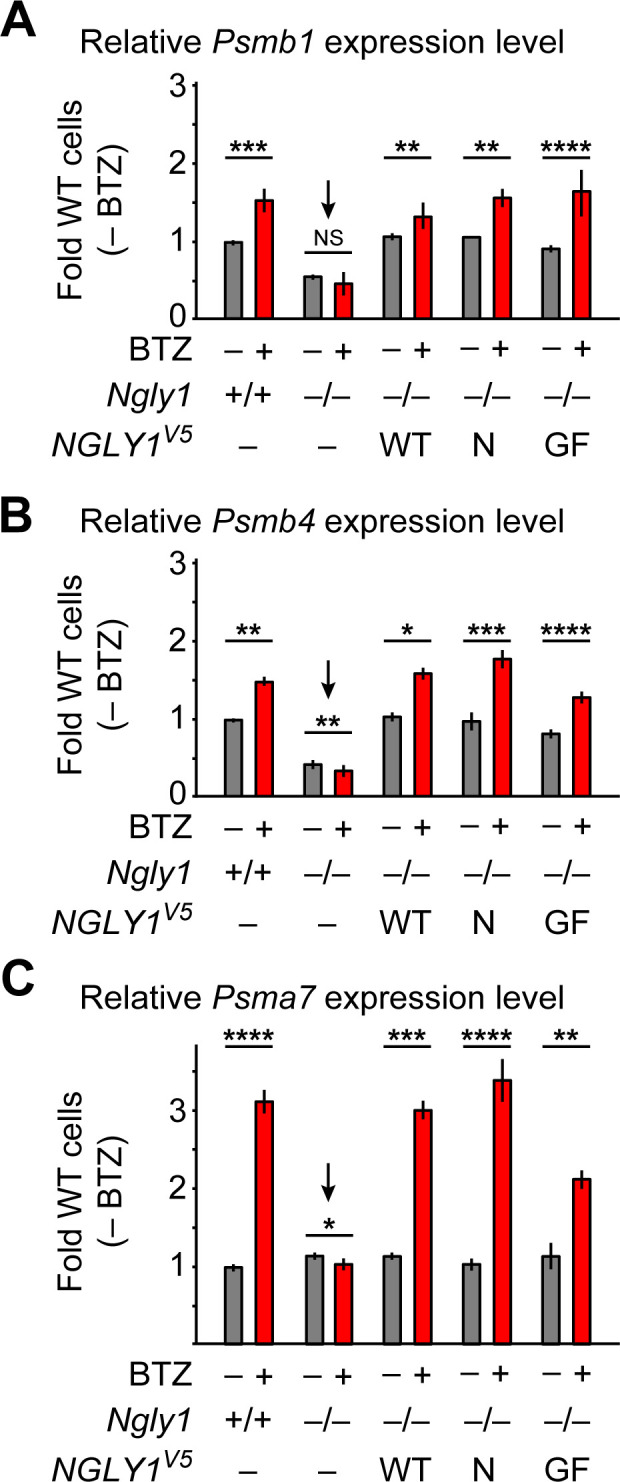
ER-associated NGLY1 is not required for NFE2L1-mediated proteasome bounce-back.(A–C) qRT-PCR assays for proteasome subunit genes in WT and Ngly1 mutant MEFs with or without bortezomib (BTZ) treatment. Ngly1 mutant MEFs were transfected with NGLY1V5-WT and NGLY1V5 with mutations in VCP-binding sites (N41P and G79A/F80A). n = 3 biologically independent samples. Two-way ANOVA test with Tukey's multiple comparisons tests was used for statistical analysis. Mean ± s.e.m. is shown. *p<0.05; **p<0.01; ***p<0.001; ****p<0.0001; NS, not significant. Despite impaired ER recruitment, the mutant NGLY1 proteins retain the ability to promote the proteasome bounce-back response, which depends on NFE2L1 deglycosylation by NGLY1 (Tomlin et al., 2017).Figure 8—source data 1.Raw data and statistical analysis for panels A-C.